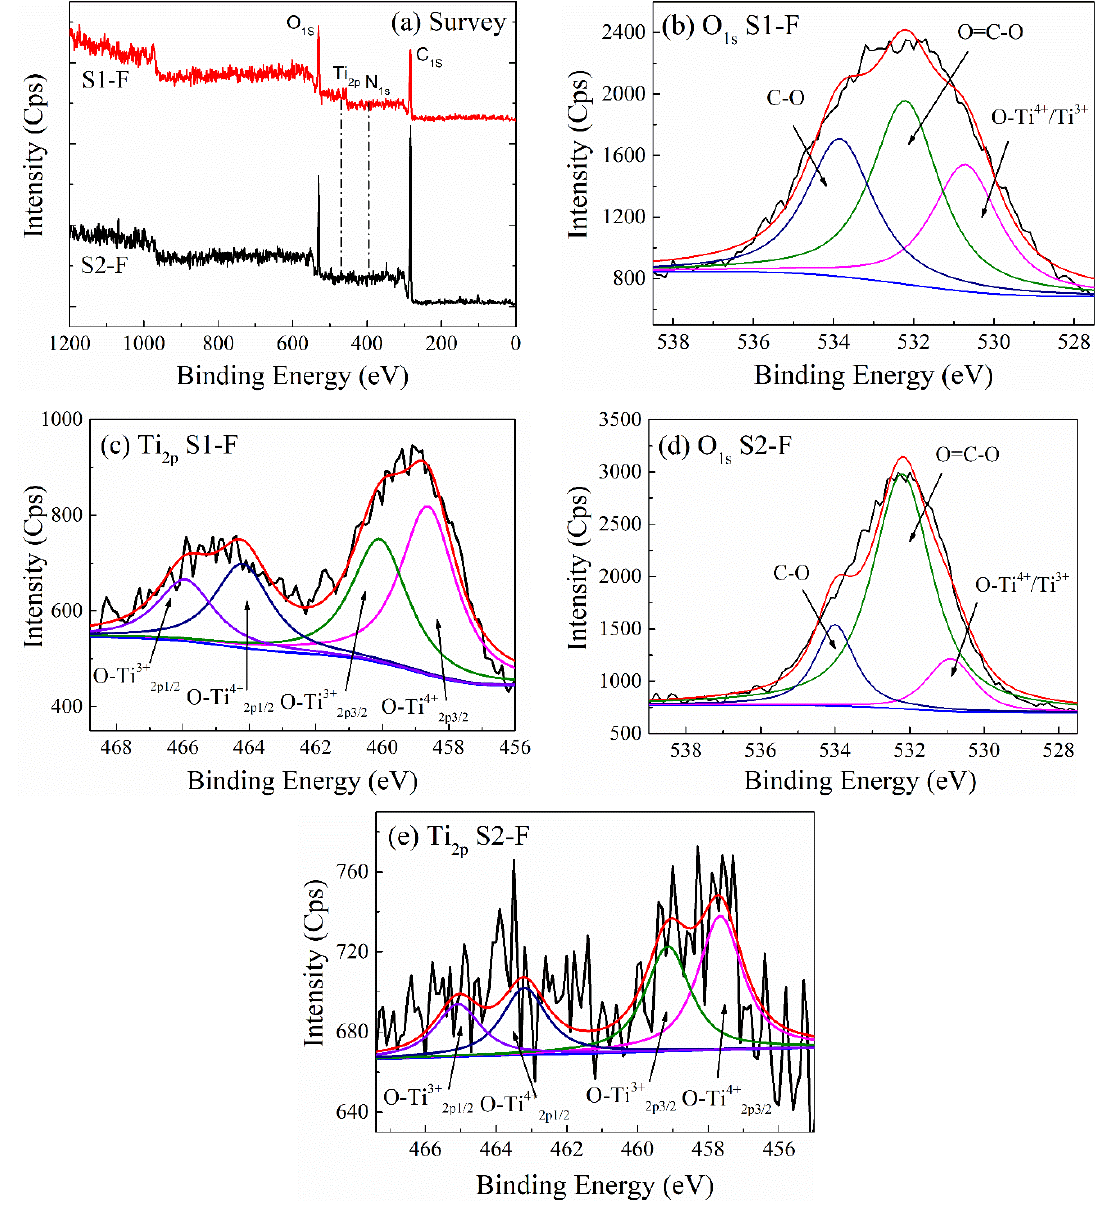
Figure 2. ( a ) Survey spectra, ( b ) O 1s and ( c ) Ti 2p for the S1–F, ( d ) O 1s and ( e ) Ti 2p for the S2–F core-level spectra.